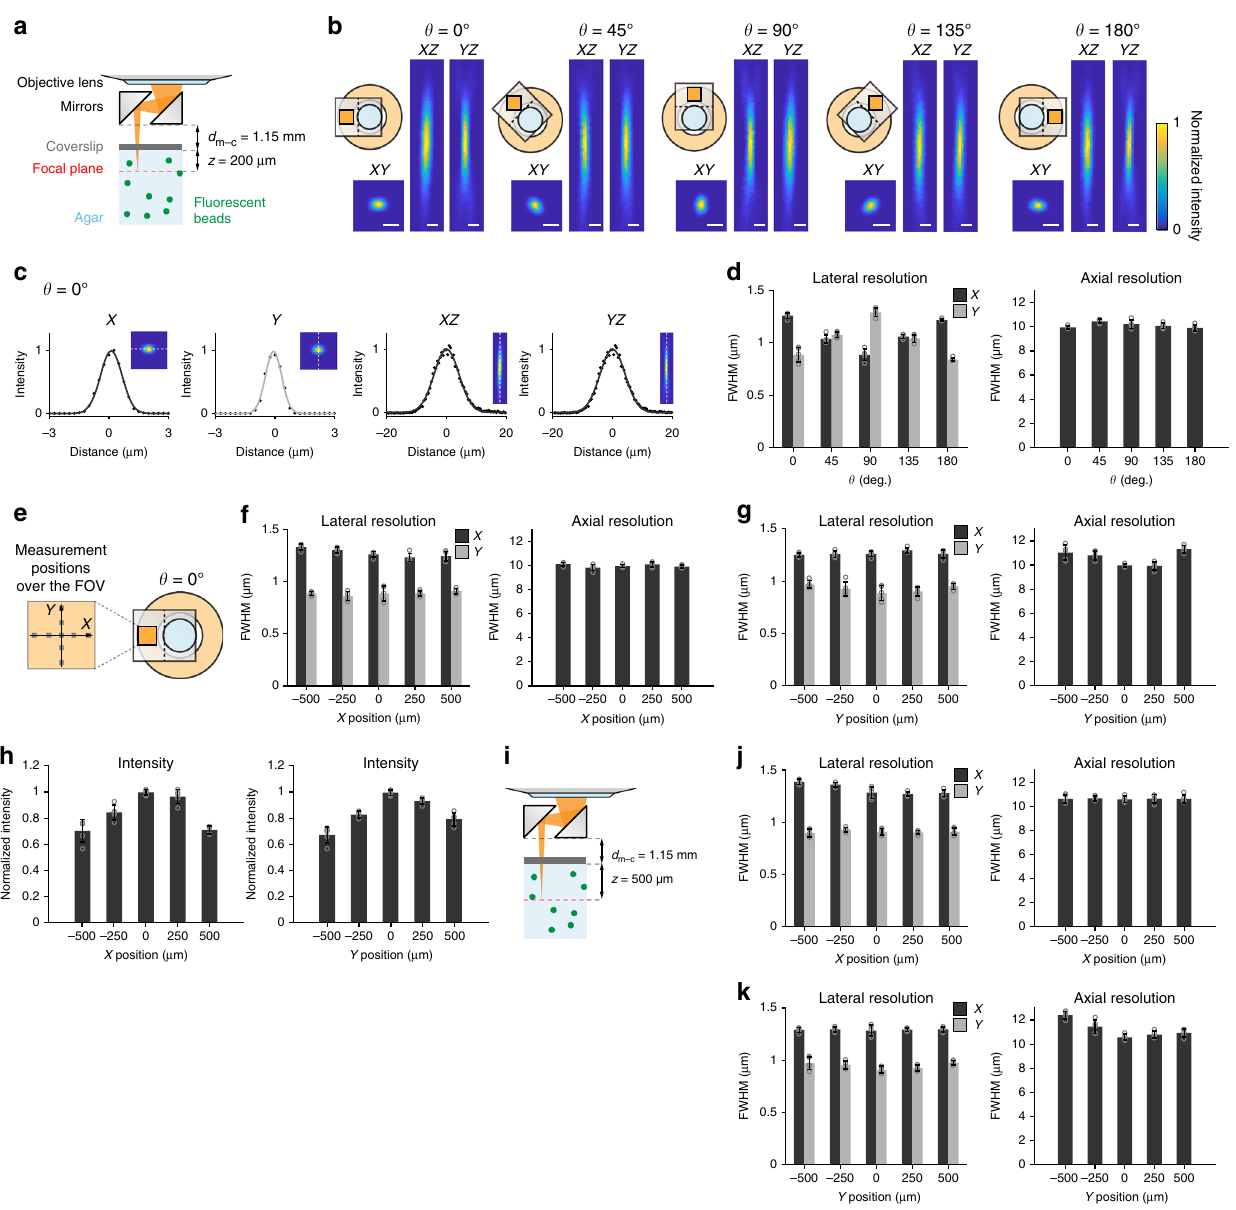
Fig. 2 Optical performance of the super-wide- fi eld TPLSM. a Measurement con fi guration for a – h . Agar-embedded 0.5 µ m fl uorescent microbeads were imaged through the device. b – d Lateral and axial FWHMs of the beads at the center of the FOV at fi ve rotation angles. b Representative XY , XZ , and YZ images of the beads at fi ve rotation angles. Scale bar, 2 µ m. c Intensity pro fi les of the bead at θ of 0° (leftmost in b ) along X -axis and Y -axis from the XY image, and Z -axis from the XZ and YZ images. The line pro fi les were acquired along the white dotted lines shown in the insets. Gray or black bold curves are fi tted Gaussian curves. d Lateral and axial FWHMs at fi ve angles. Each axial FWHM is an average of the axial FWHMs estimated from the XZ and YZ images. Five different beads were measured for each point. Gray dots indicate individual bead measurements. Data are plotted as mean ± s.d. e Measurement positions over the FOV for f – h , j , and k . θ was set at 0°. f , g Lateral and axial FWHMs of the beads along the X -axis ( f ) and Y -axis ( g ). h Normalized intensity of the beads along the X -axis and Y -axis. i The measurement con fi guration for j and k . j , k Lateral and axial FWHMs of the beads along the X -axis ( j ) and Y -axis ( k pixels) is 33.3 ms; therefore, the ideal frame rate for dual- fi eld imaging ( θ = 60°, or 2.5 mm apart) is 6.6 Hz. To test the performance of the micro-opto-mechanical device, we con- tinuously imaged fl uorescent microbeads in two small FOVs at a distance of 2.5 mm during device rotation of 60° back and forth (Fig. 3b and Supplementary Movie 1). The timing of each device rotation was precise, with the image position being settled immediately after the end of the rotation (Fig. 3b).